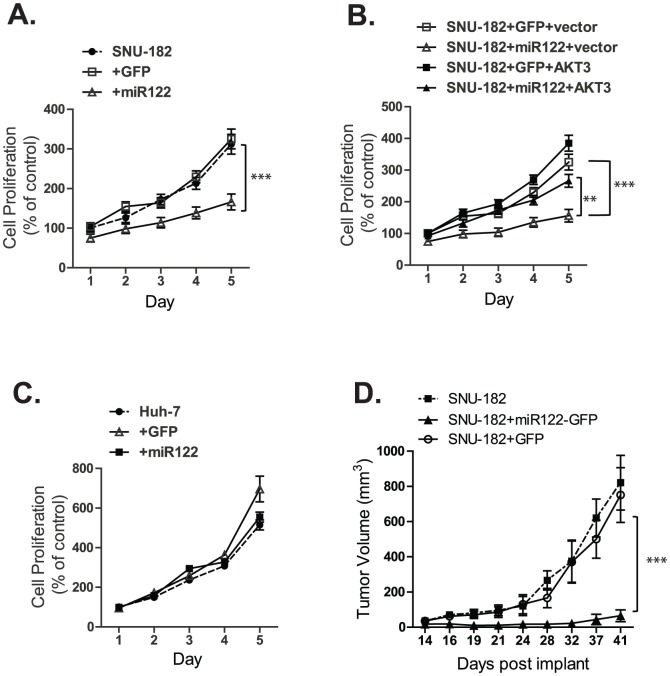
miR-122 over-expression inhibited in-vitro cell proliferation and in-vivo tumor growth in a highly transformed HCC SNU-182 xenograft mouse model.Cell proliferation was measured in (A) SNU-182 and (C) Huh-7 parental cells and cells stably over-expressing miR-122-GFP or GFP alone. (B) Cell proliferation was measured in SNU-182 cells over-expressing miR-122-GFP or GFP with or without the reconstitution of AKT3 expression. (D) Nude mice were implanted with SNU-182 parental lines as well as cells over-expressing miR-122-GFP or GFP vector alone, and tumor growth was monitored and plotted as tumor volume (mm3) over time. Statistical significance between the indicated groups are depicted as ** P<0.01, and *** P<0.005.